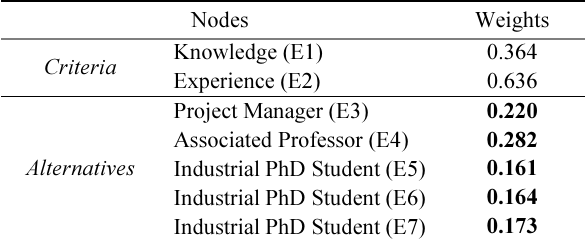
Table 8. Expert’s weights Nodes Weights Criteria